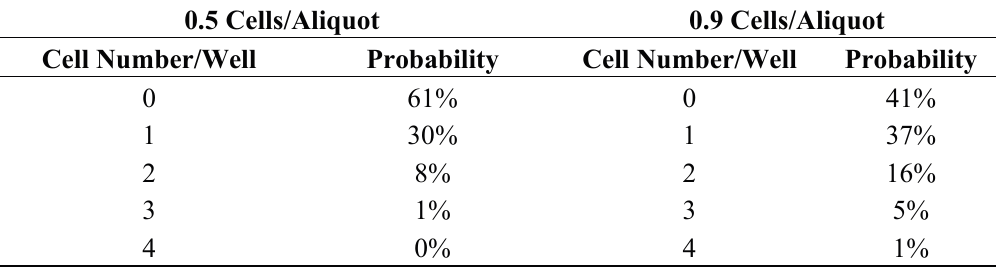
distribution for cell concentrations of 0.5 and 0.9 cells per